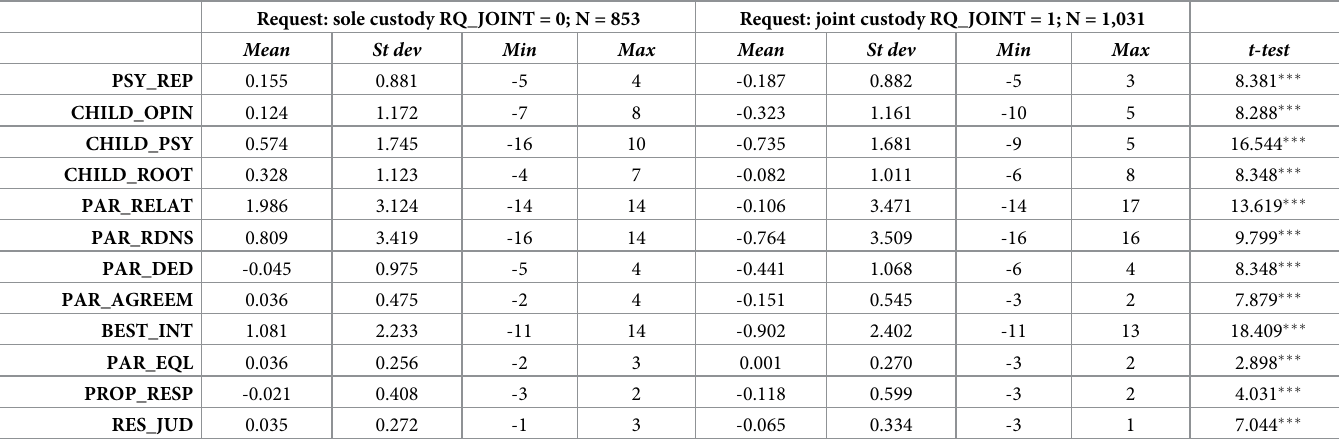
Table 4. Sample descriptives using t-test for equality of